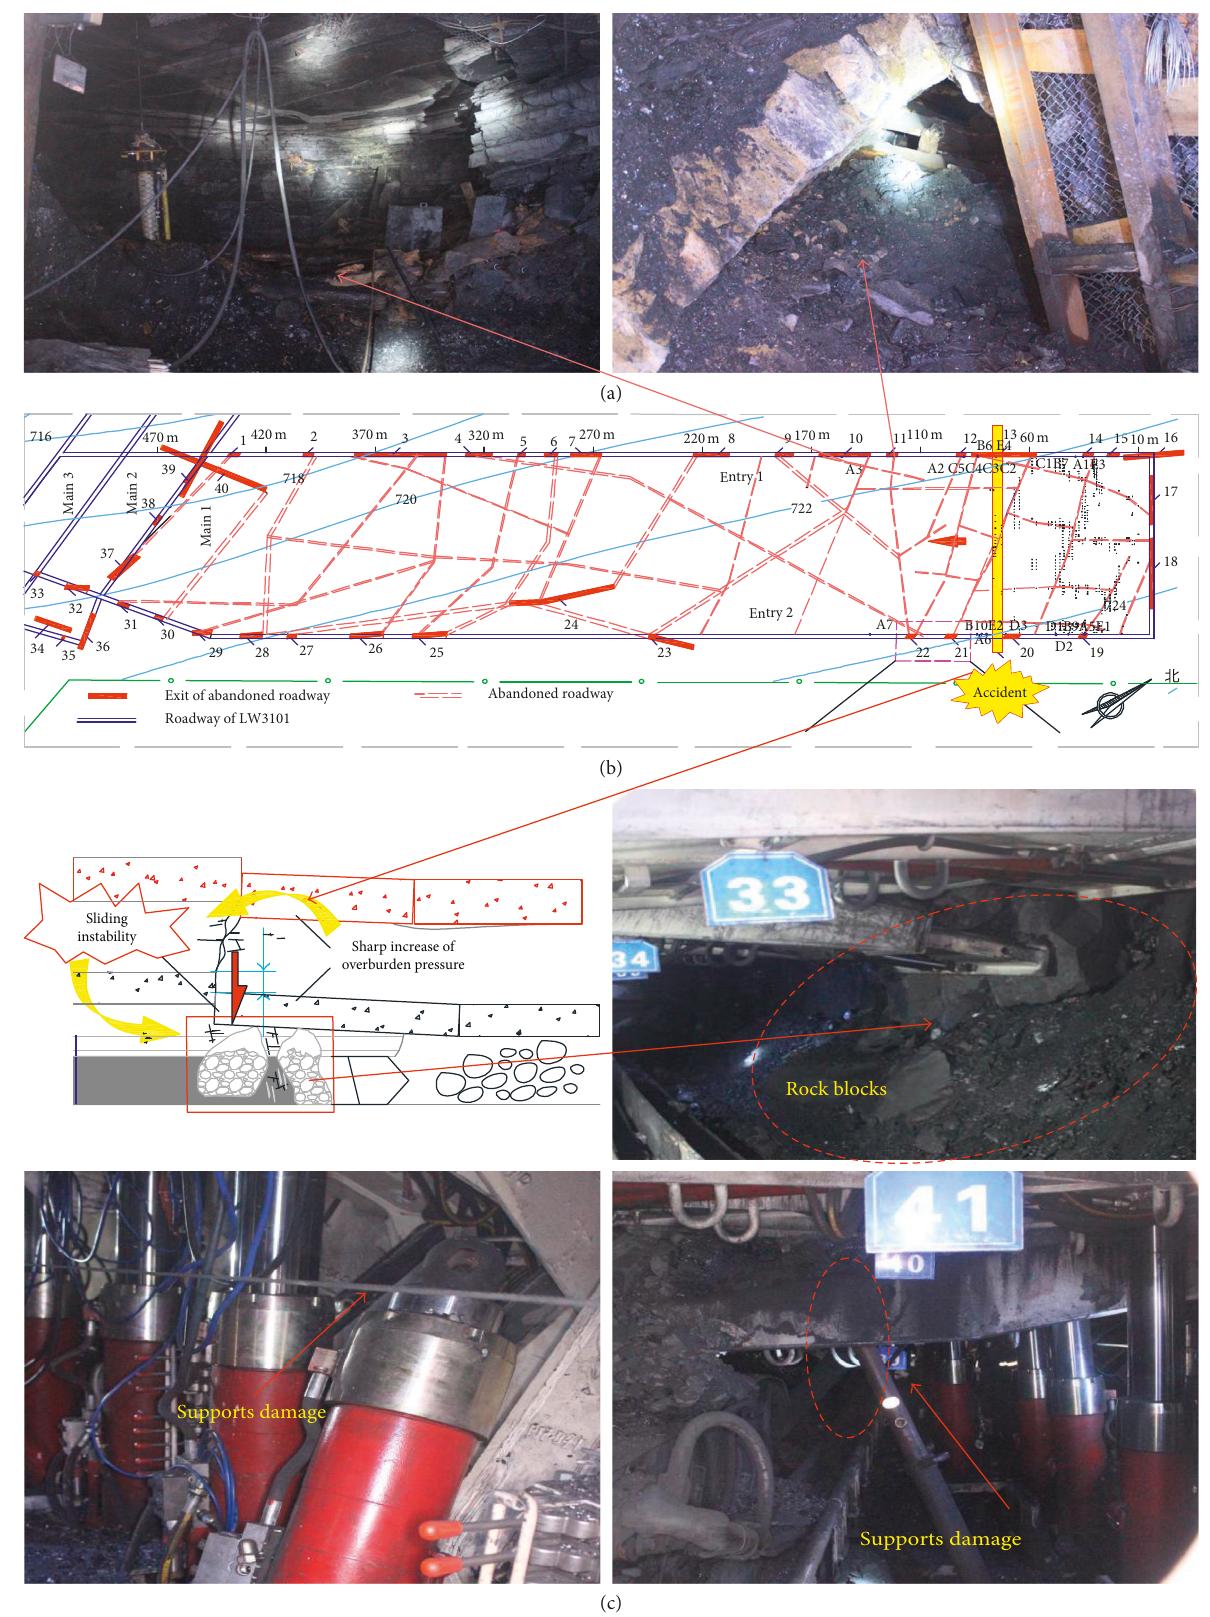
Figure 3: (a) Conditions of entry 1 during the drivage period. (b) Layout of LW3101 and abandoned roadways. (c) Sketch map of the strata behavior and photograph of the